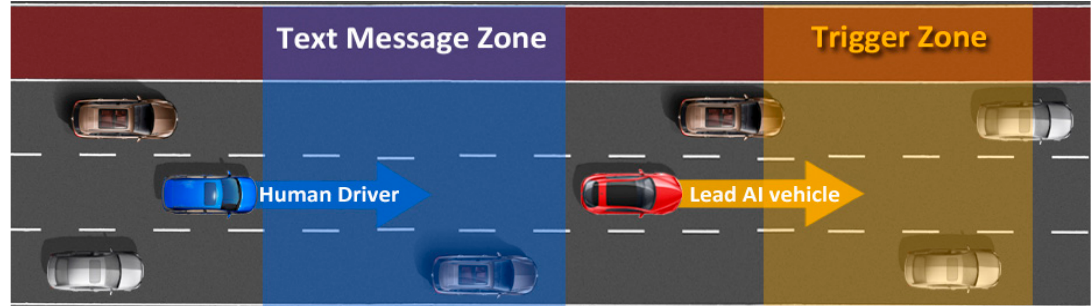
Figure 9. Creation of collision prone scenarios by Artificial Intelligence (AI)—controlled vehicles. To immerse the driver further, a digital twin of the city of Glasgow’s surrounding motorways has been modelled. The selected routes of M8, M73, and M80 formed a 28 miles triangle which is the busiest part of the road-network connecting Glasgow to Edinburgh and Stirling whilst offering the path to the north in Highlands and to the south towards North England as depicted in Figure 10.